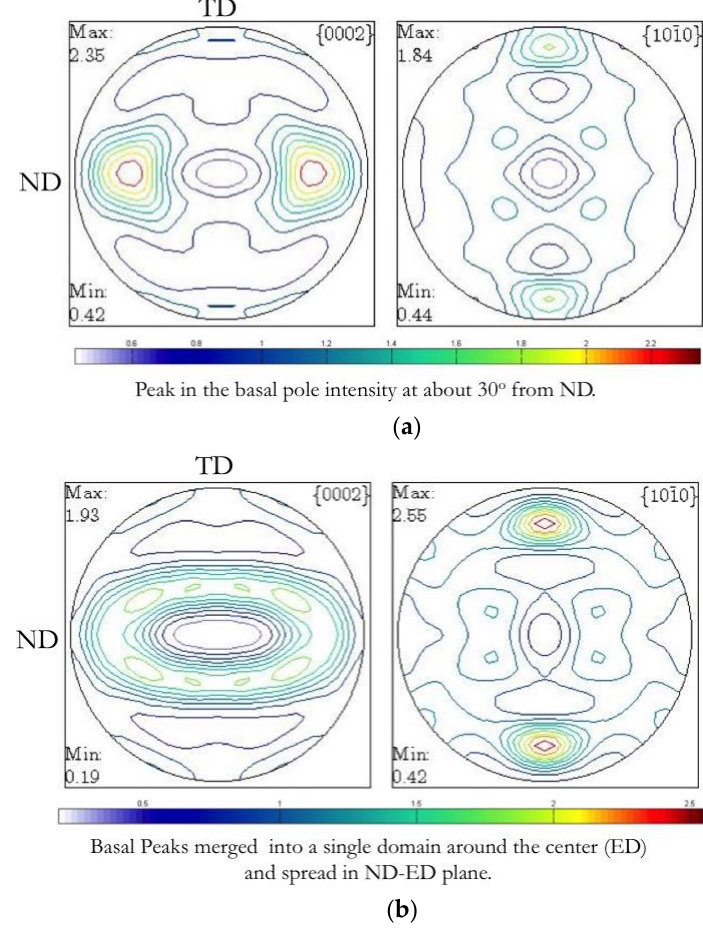
Figure 10. XRD pole figures of the specimens deformed under ND loading for the conditions corresponding to Domain 1 of the ND processing map. ND (the compression axis) is along the horizontal axis and the vertical axis is TD. ( a ) 250 °C and 0.0003 s −1 (Domain 1); ( b ) 300 °C and 0.0003 s −1 (Domain 1).